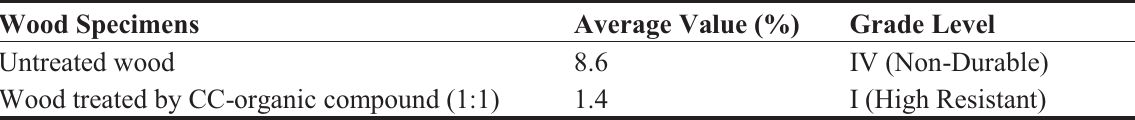
Table 2. The result of weight loss percentage of dry wood termite test.